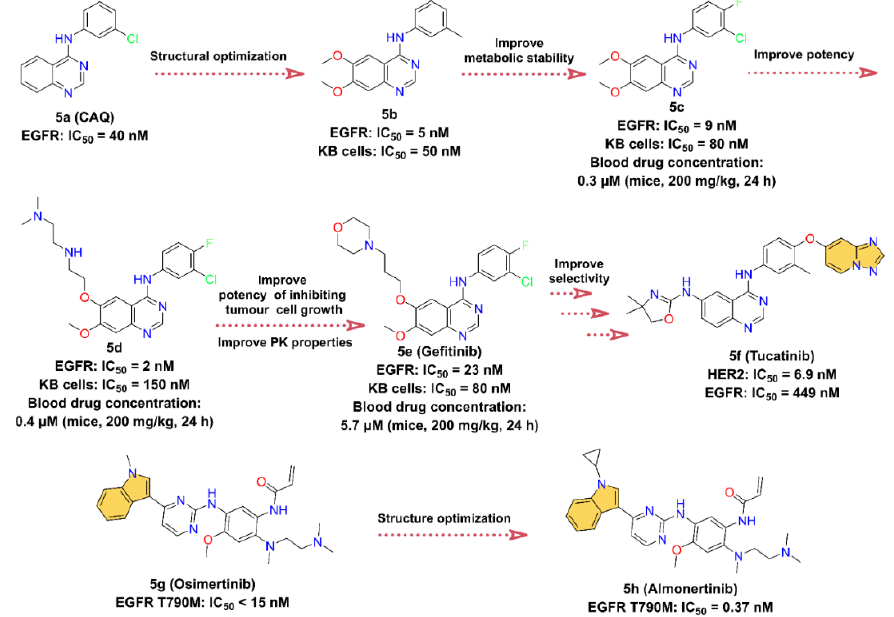
Figure 5. Key medicinal chemistry optimization of Tucatinib , Osimertinib , and Almonertinib